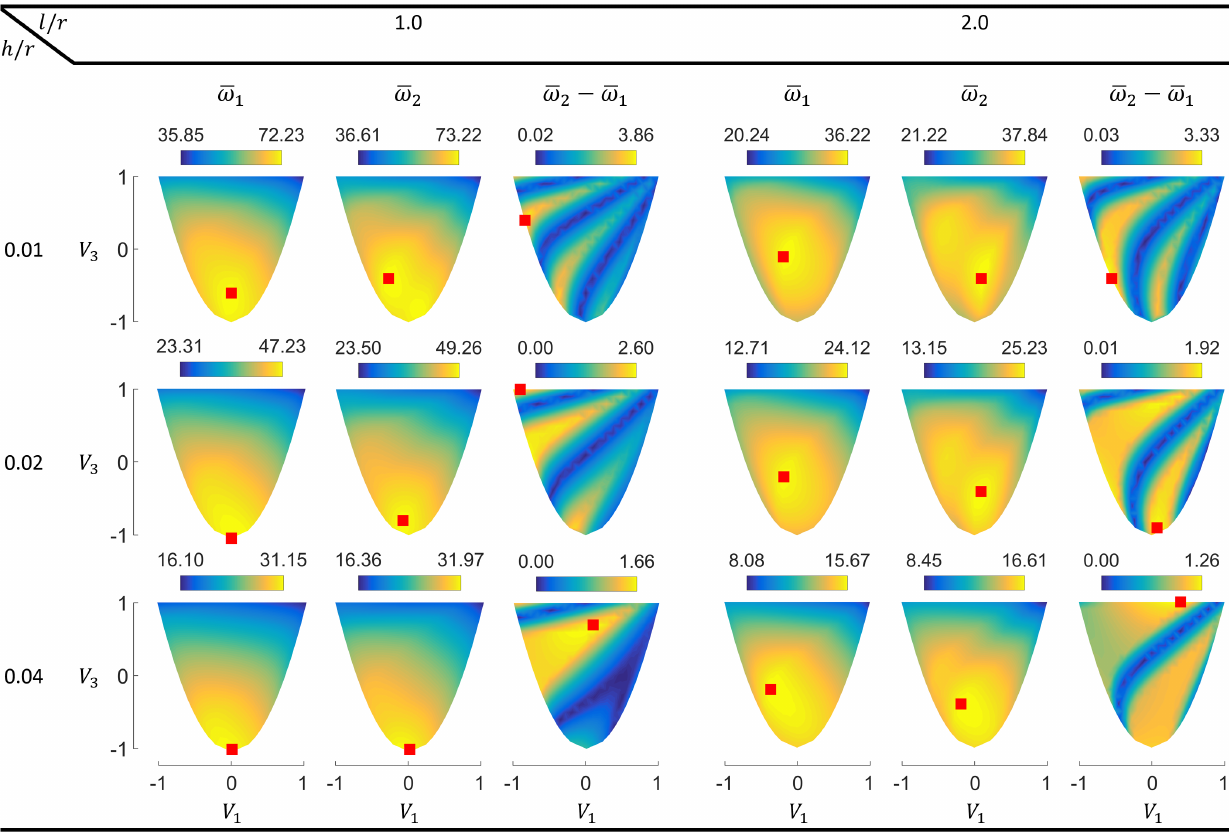
Figure 2. Lamination parameter plane contours of the first two normalized eigenfrequencies and their differences for simply supported circular composite